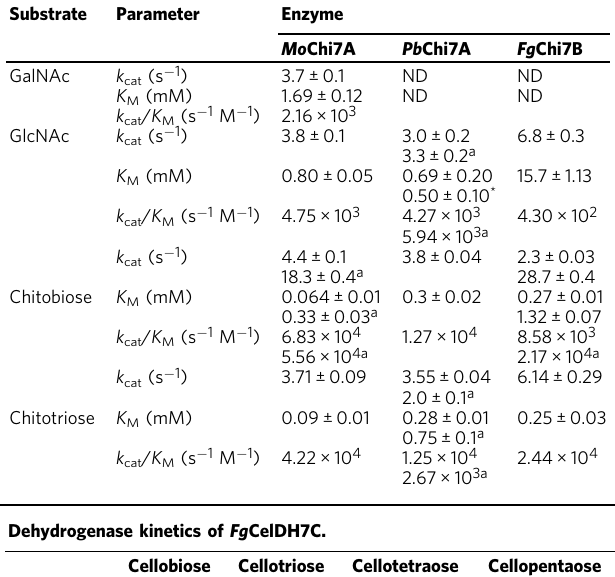
Table 1 Apparent kinetic parameters of AA7-catalysed oxidation of saccharides.